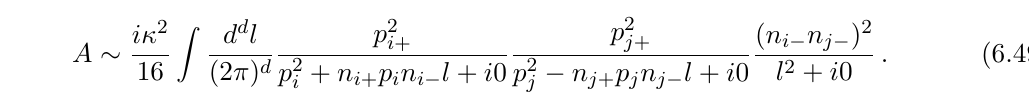
Figure 4 . Diagram classes modifying the soft emission process, where the soft loop connects two legs of different directions. The soft-collinear interactions are present starting from a = b = 0 . Due to multipole expansion, soft-collinear vertices are only sensitive to the n on-shell legs, the soft loop vanishes unless a soft scale, provided by the injection of the full soft momentum k , is present. This can only happen by a purely-soft interaction vertex. Hence, only the last diagram has a non-vanishing contribution. Here, c ≥ 2 as it is a purely-soft interaction, and the loop is suppressed by λ 2 in